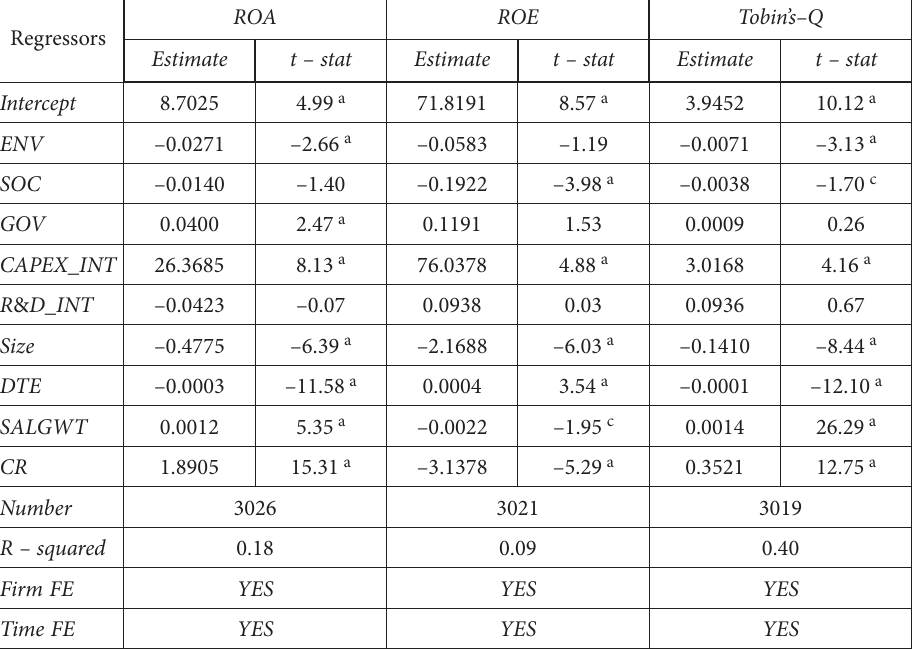
Note : Table shows the regression output for the Eq. (1), showing the link between the sub-dimension of ESG practice and firms’ financial performance. Robust standard errors for the test’s statistics. Significant at a 1%, b 5%, c 10%